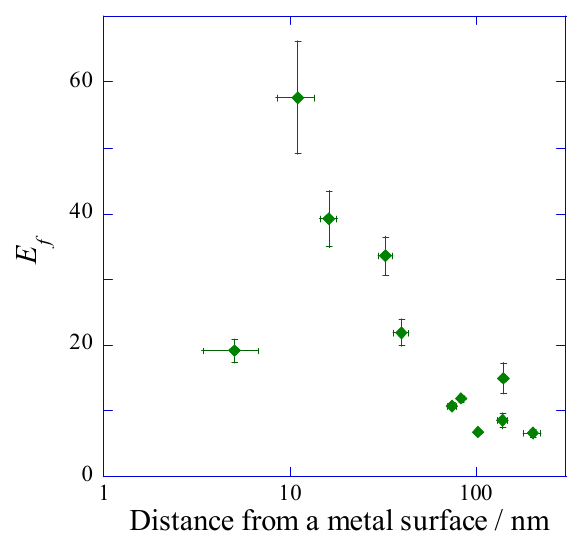
Figure 7. Fluorescence enhancement factor multiplied the normalized peak value to base value for DAS and that for IAS.